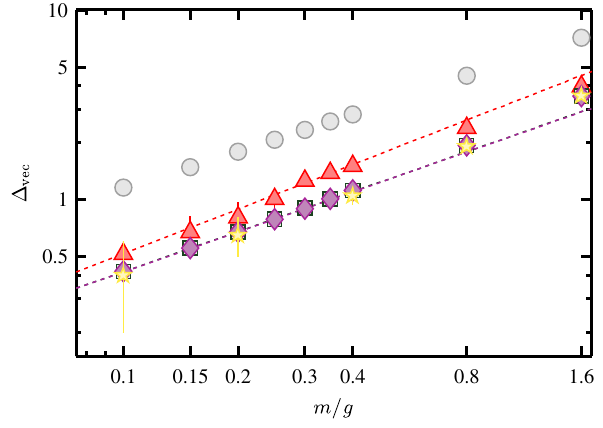
TABLE I. Critical exponent for various values of j 1 error is the fitting error with respect to a 1 σ confidence interval, FIG. 7. Vector state mass gap as a function of m=g for j max ¼ 3 = 2 (green squares), and j 2 (ma- the second one the systematic error (for more details, see (red triangles), j max ¼ max ¼ Appendix genta diamonds) on double logarithmic scale. The yellow stars represent the numerical values obtained from the strong coupling expansion [55]. The dotted lines represent the best fit of the form γ ð m=g Þ ν to the data obtained on the interval ½ 0 . 1; ð m=g Þ (cid:4) with max 0 . 25 ≤ ð m=g Þ ≤ 0 . 4 . For completeness, we also show the data max 1 = 2 (light gray circles), although in this case our for j max ¼ lattice spacings do not allow for a reliable estimate.